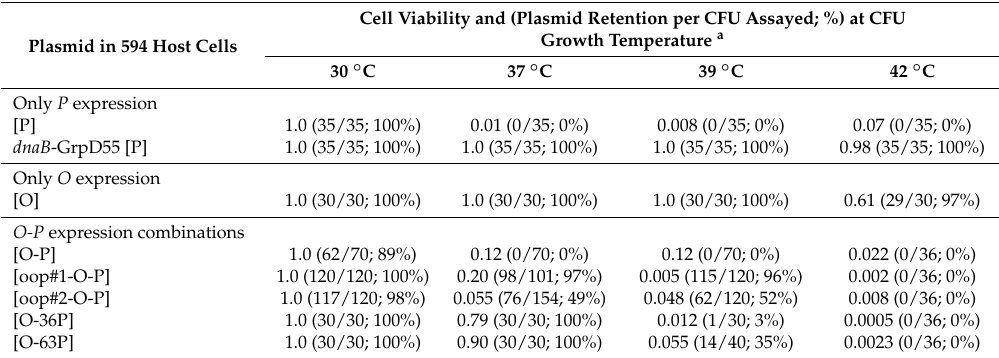
Table 3. Does O-P co-expression temper P-lethality and plasmid loss?